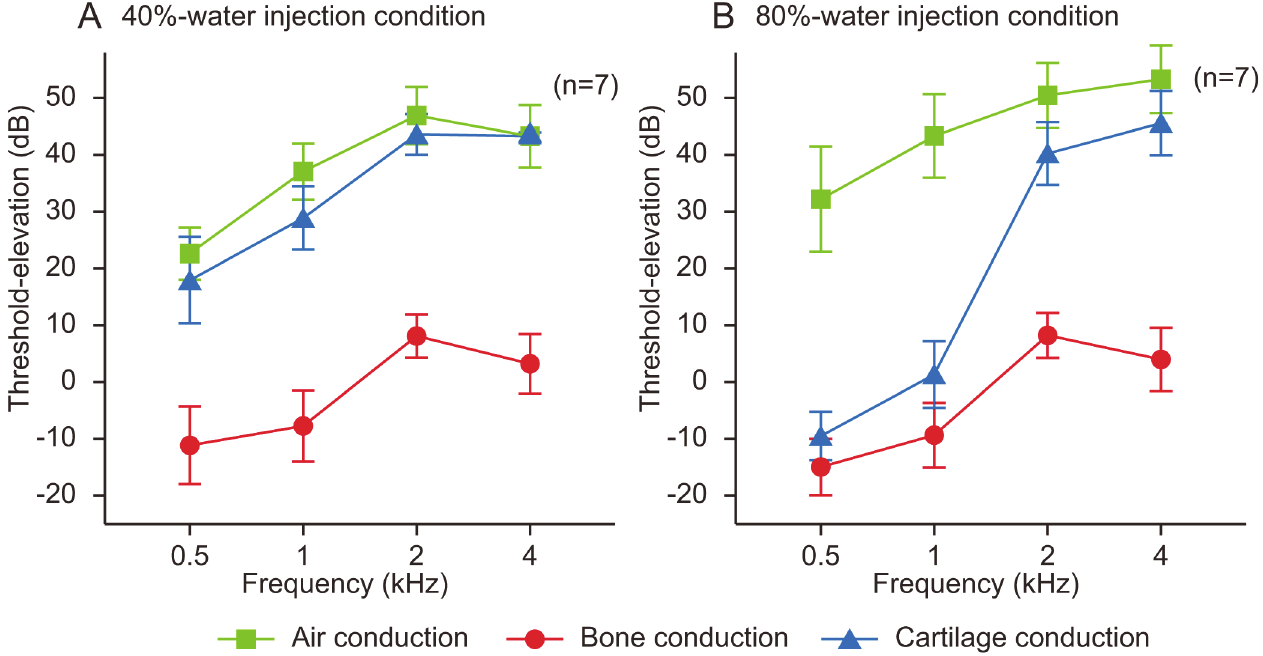
Fig 4. Threshold-shifts by the 40%- (A) and 80%- (B) water injections. Threshold-shifts from the 0%-water injection condition were described. The additional water injection from 40% to 80% of the ear canal remarkably improved the cartilage conduction thresholds at 0.5 and 1 kHz. Vertical bars indicate standard